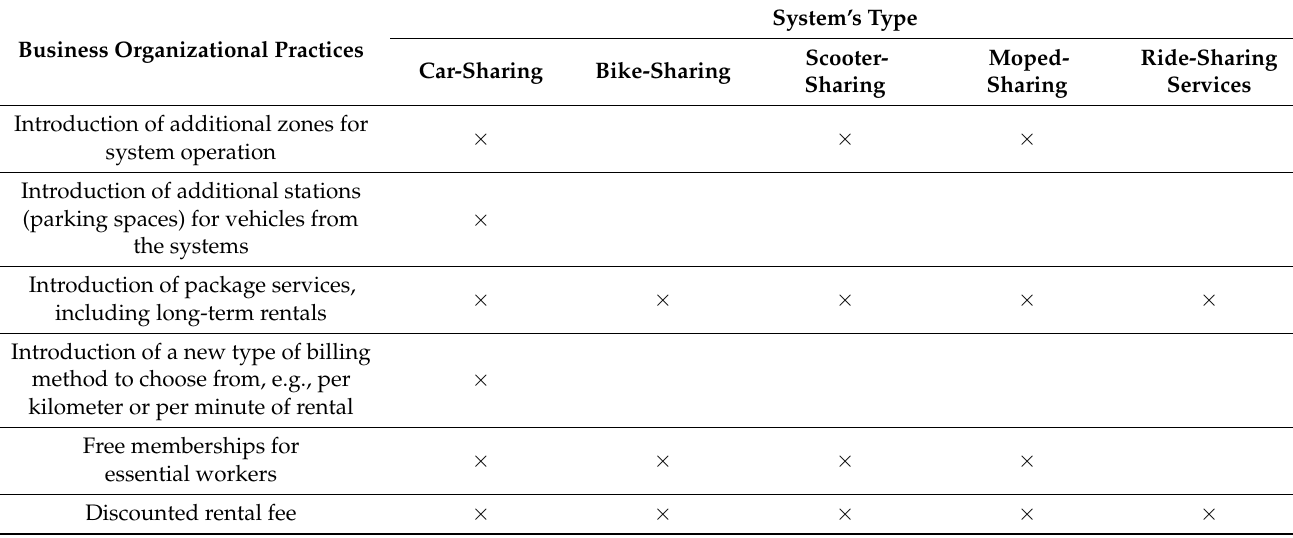
Table 3. Comparison of business practices in new mobility systems—management and organizational issues.